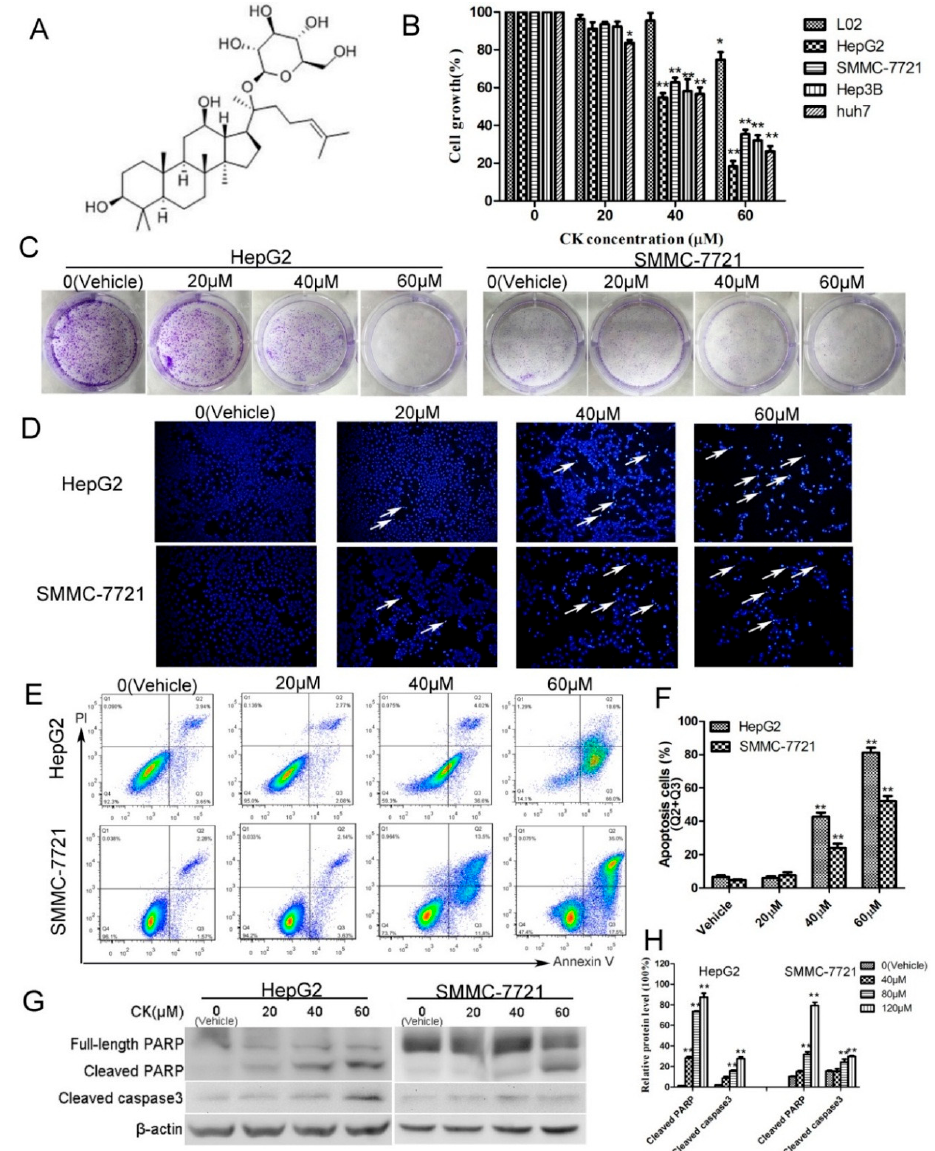
Figure 1. CK inhibited the growth of HepG2 and SMMC-7721 cells by inducing apoptosis. ( A ) Chemical structure of CK. ( B ) HepG2, SMMC-7721, Hep3B, Huh7 and L02 cells were treated with 0, 20, 40, and 60 µ M CK for 48 h, and cell viability was measured by the MTT assay; Statistics were done by one-way ANOVA and Dunnett text. * p < 0.05, ** p < 0.01 vs. Vehicle. ( C ) HepG2 and SMMC-7721 cells were